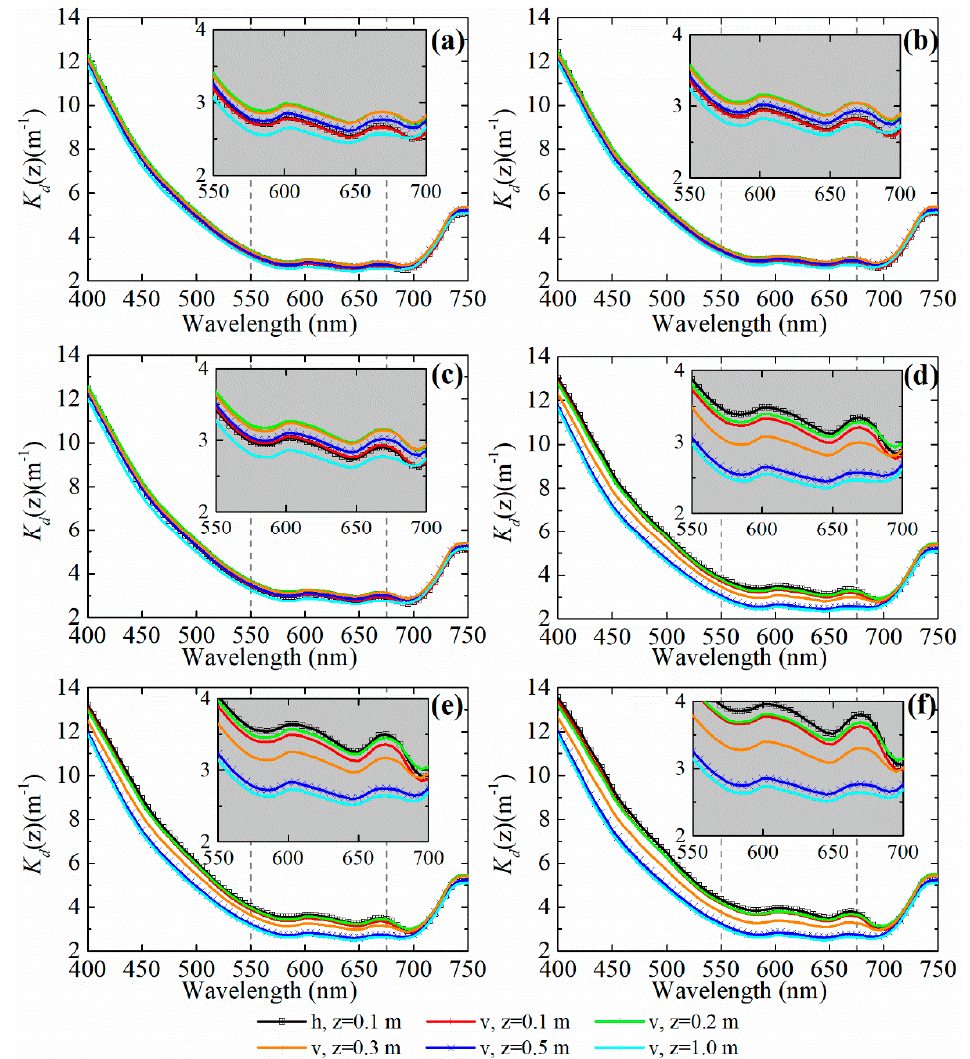
Figure 4. K d (z) spectrum of Chl a (z) profiles: ( a ) L1 (5, 16, 0.6), ( b ) L2 (10, 16, 0.6), ( c ) L3 (10, 21, 0.6), ( d ) L4 (5, 16, 0.2), ( e ) L5 (10, 16, 0.2), and ( f ) L6 (10, 21, 0.2) at different water depths (z = 0.1, 0.2, 0.3, 0.5, 1.0 m). The inserted figures showed the K d ( λ , z) in the range of 550 nm to 700 nm of each Chl a (z) profiles. “h” represents that the Chl a value was vertical homogeneous, and the water depth is 0.1 m. “v” represents the vertical inhomogeneous cases. K d vertical profiles at 550 and 675 nm (grey dash lines) were showed in Figures 5 and 6, respectively.